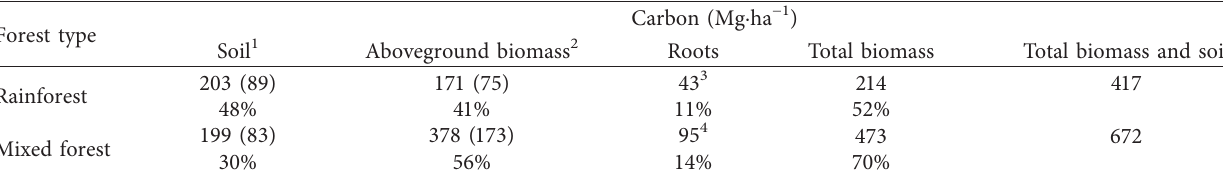
Figure 5: Estimation graphs [45] comparing C/N ratios of soils under rainforest and mixed forests for (a) uppermost (A1 or B1) horizons and (b) lowermost (B3, C, BCg, or Bhs) horizons. The 95% confidence interval, indicated by vertical black bars, is obtained via bootstrap resampling (5000 repetitions). The horizontal black lines represent mean C/N ratios for each forest type. The vertical curve indicates the resampled distribution. Table 4: Estimated mean C pools in mixed forests and rainforests of Tasmania and C in each pool expressed as a percentage of total C in the ecosystem. Standard deviations in